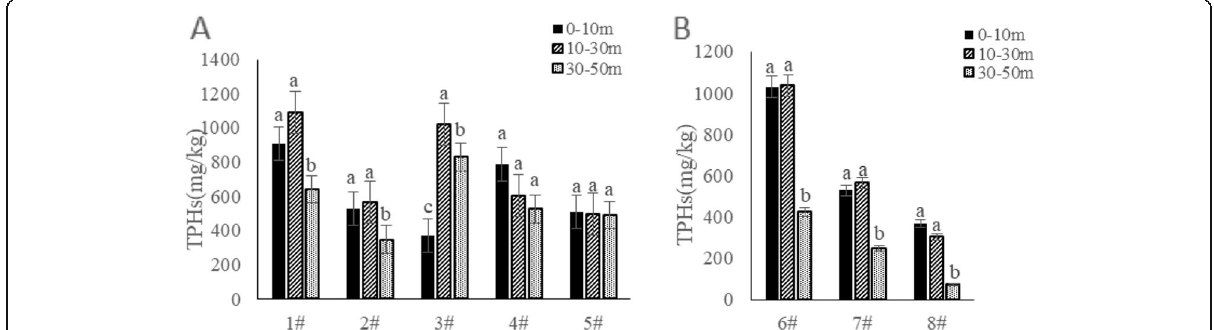
Fig. 1 Distribution characteristics of soil essential nutrients in different regions of oil well area